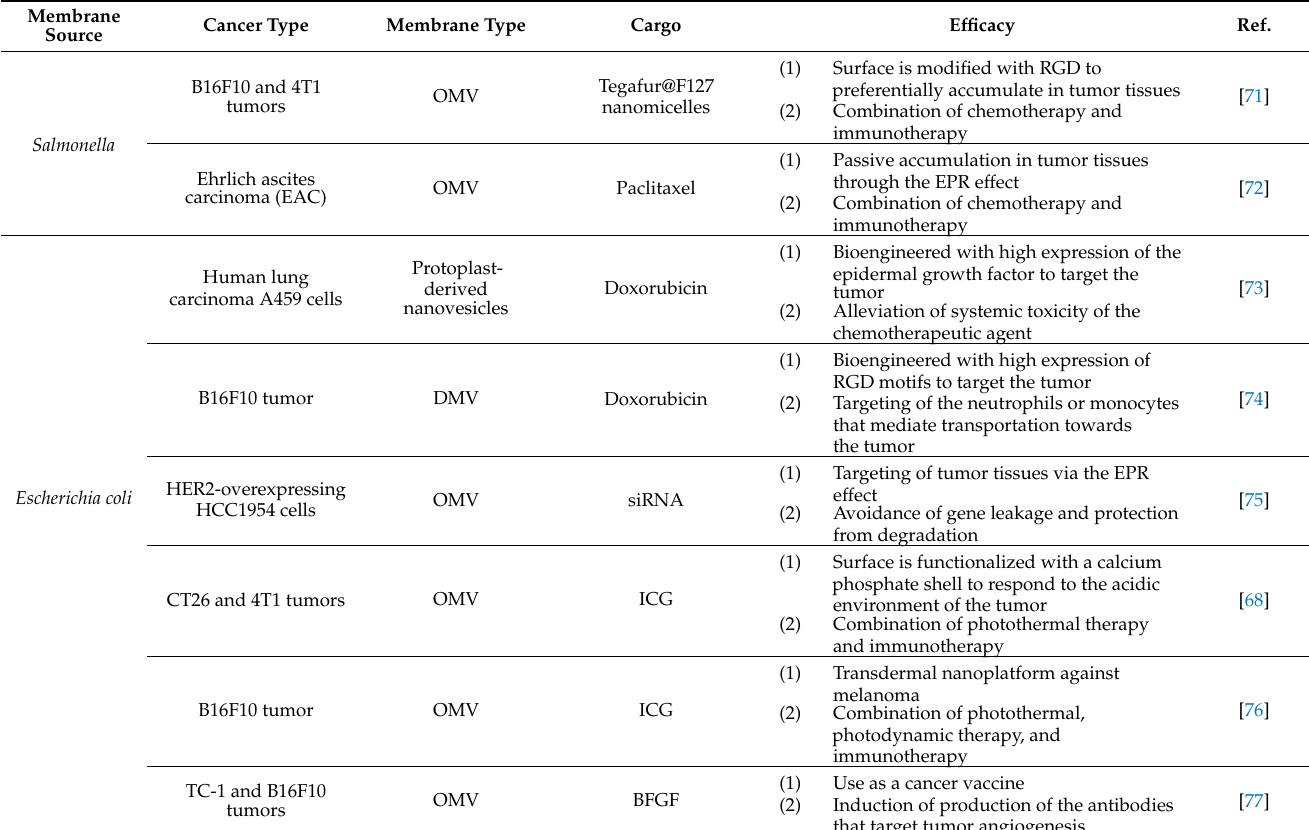
Table 2. Bacteria membrane-based nanoparticles in cancer